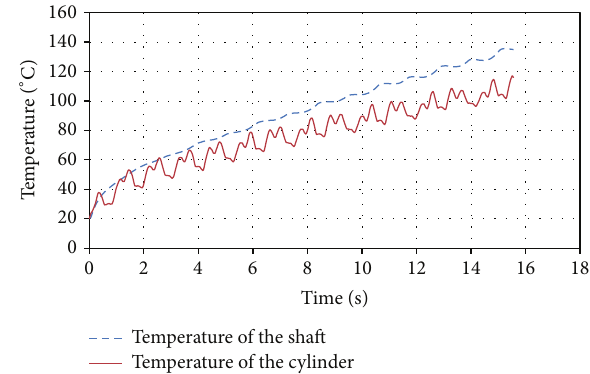
Figure 13: Hysteretic force-displacement curve of the improved CFD (7 cycles and frequency = 0.45 Hz).